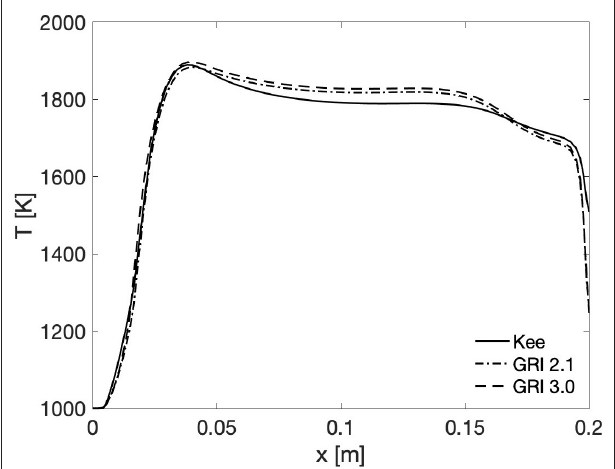
FIGURE 3 | Case 1 comparison between FGM and PaSR with C mix of 0.01, 0.1, and 0.5 and experimental values along the central and lateral thermocouples. (A) Central thermocouple profiles. (B) Lateral thermocouple profiles.